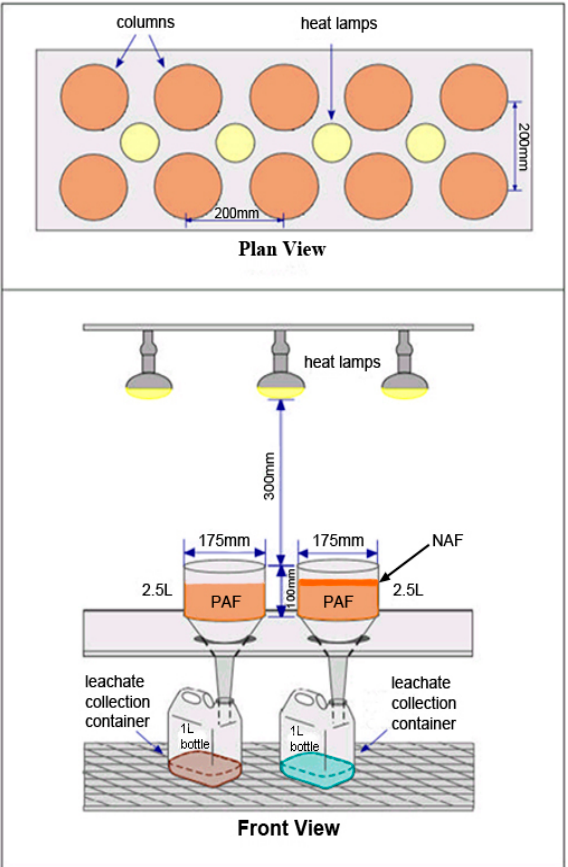
Figure 1. Schematic overview (modified from Figure F1 in [12]) of the KLC setup using conventional Büchner funnels with circular Whatman ® cellulose filters (8 μ m pore size, provided by Sigma-Aldrich, Castle Hill, Australia) placed at the bottom of the solid wastes. Each synthetic waste KLC contained only PAF material (synthetic mixtures of single minerals including pyrite).